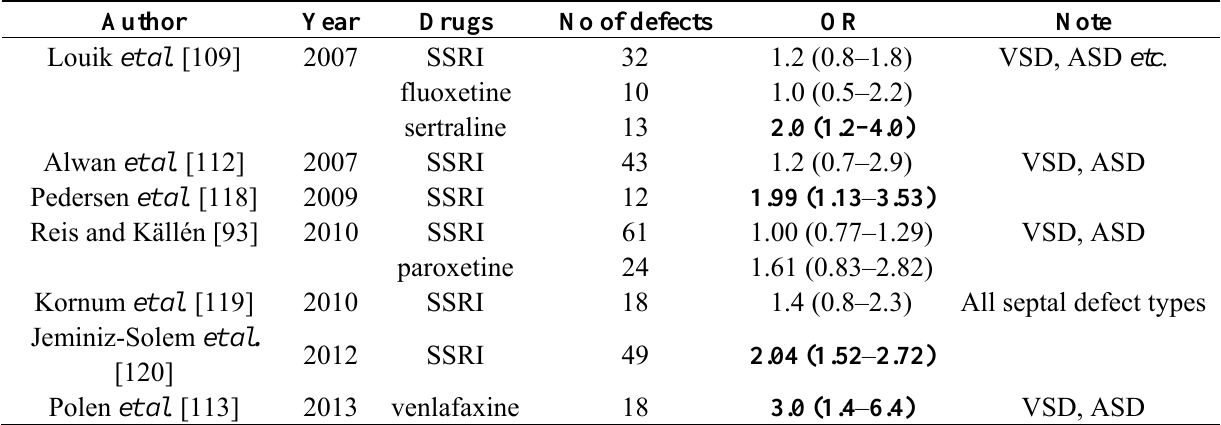
Table 31. Publications giving risk for cardiac septum defects after maternal use of antidepressants. Bold text marks statistical significance.